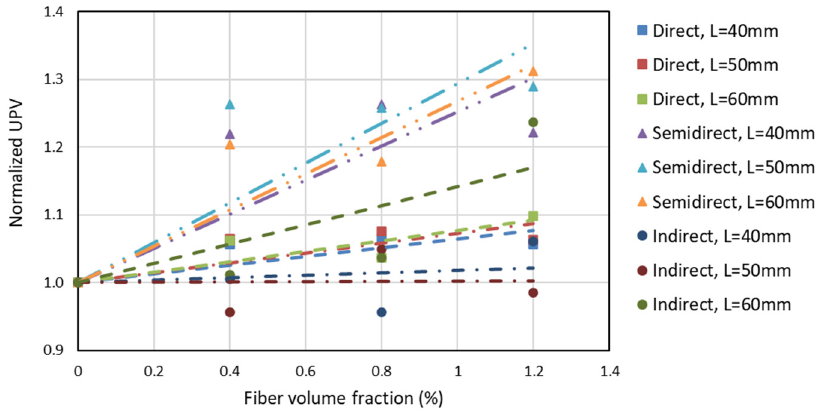
Figure 11. The ratio between fiber length and the normalized ultrasonic pulse velocity.